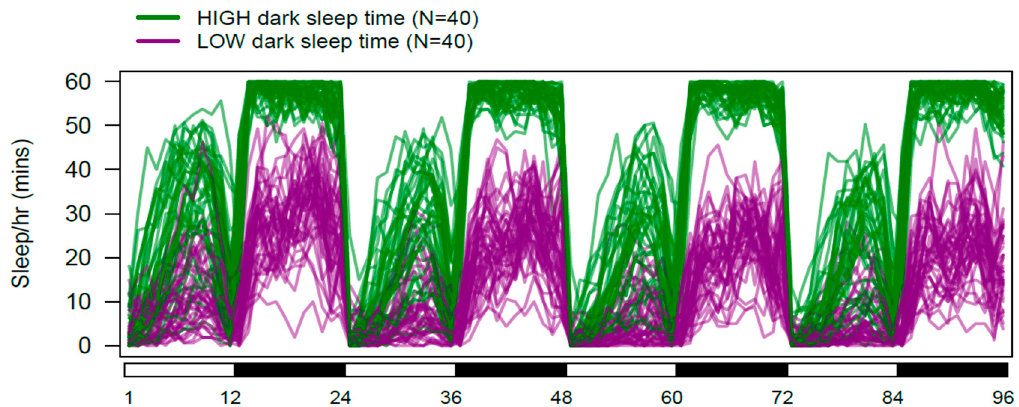
Figure 2. Daily sleep in DSPRF1 genotypes exhibiting extreme dark-phase sleep time. The 40 DSPRF1 genotypes with the highest, and the 40 with the lowest average dark-phase sleep time were identified. For each of these genotypes, we calculated the average sleep time per hour per fly throughout the 96 h data collection period. The figure shows 80 overlapping sleep profiles, with those in green from high dark-phase sleep genotypes, and those in purple from low dark-phase sleep genotypes.